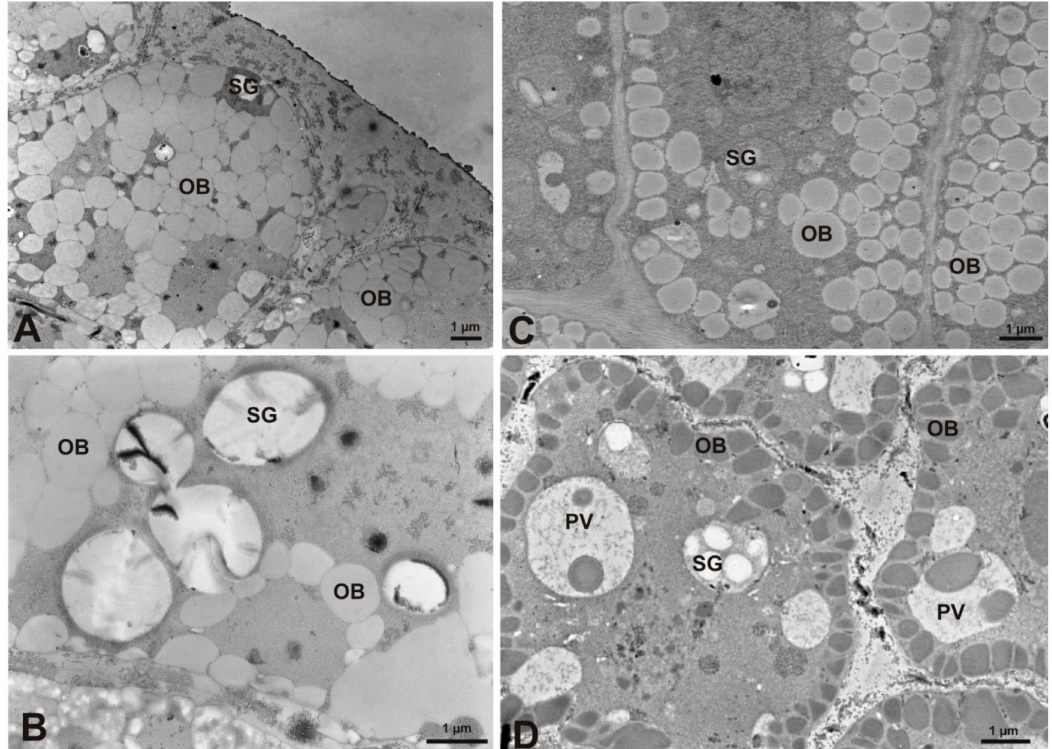
Figure 2. Ultrastructure of the cotyledons ( A , B ) and embryonic axes ( C , D ) of dry Fagus sylvatica seeds was performed to illustrate the arrangement of storage materials, especially oil bodies. Cells of the epidermal layer ( A , C ) and deeper layers ( B , D ) were visualized using transmission electron microscopy. Abbreviations: OB–oil body, SG–starch grain, PV–protein